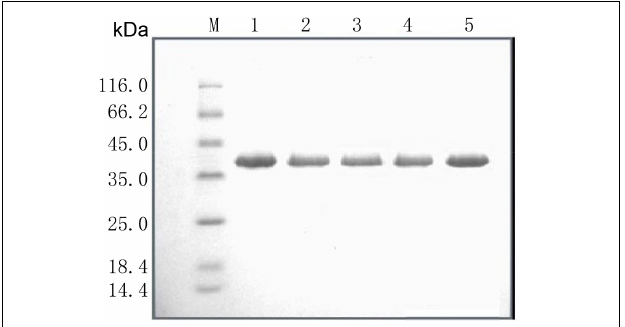
FIGURE 1 | SDS-PAGE analysis of the recombinant lipases. M: standard protein molecular mass markers; Lanes 1–5: Lipr27RCL, Lipr27RCL-K64N, Lipr27RCL-W65, Lipr27RCL-D66T, and Lipr27RCL-K68T,